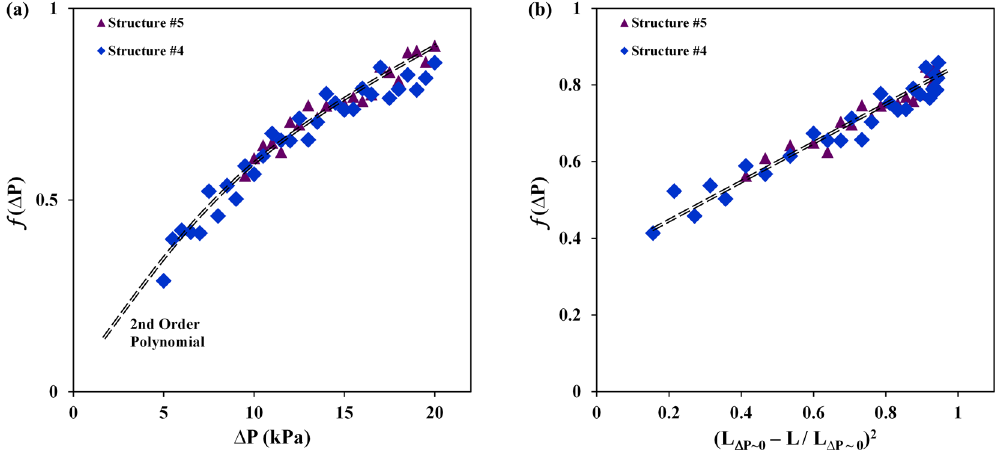
Figure 8. Variations of f with ( a ) the applied liquid pressure and ( b ) available wicking area (values for f ( Δ P ) are calculated by normalizing the CHF values associated with structures 4 & 5 with that of structure #3).